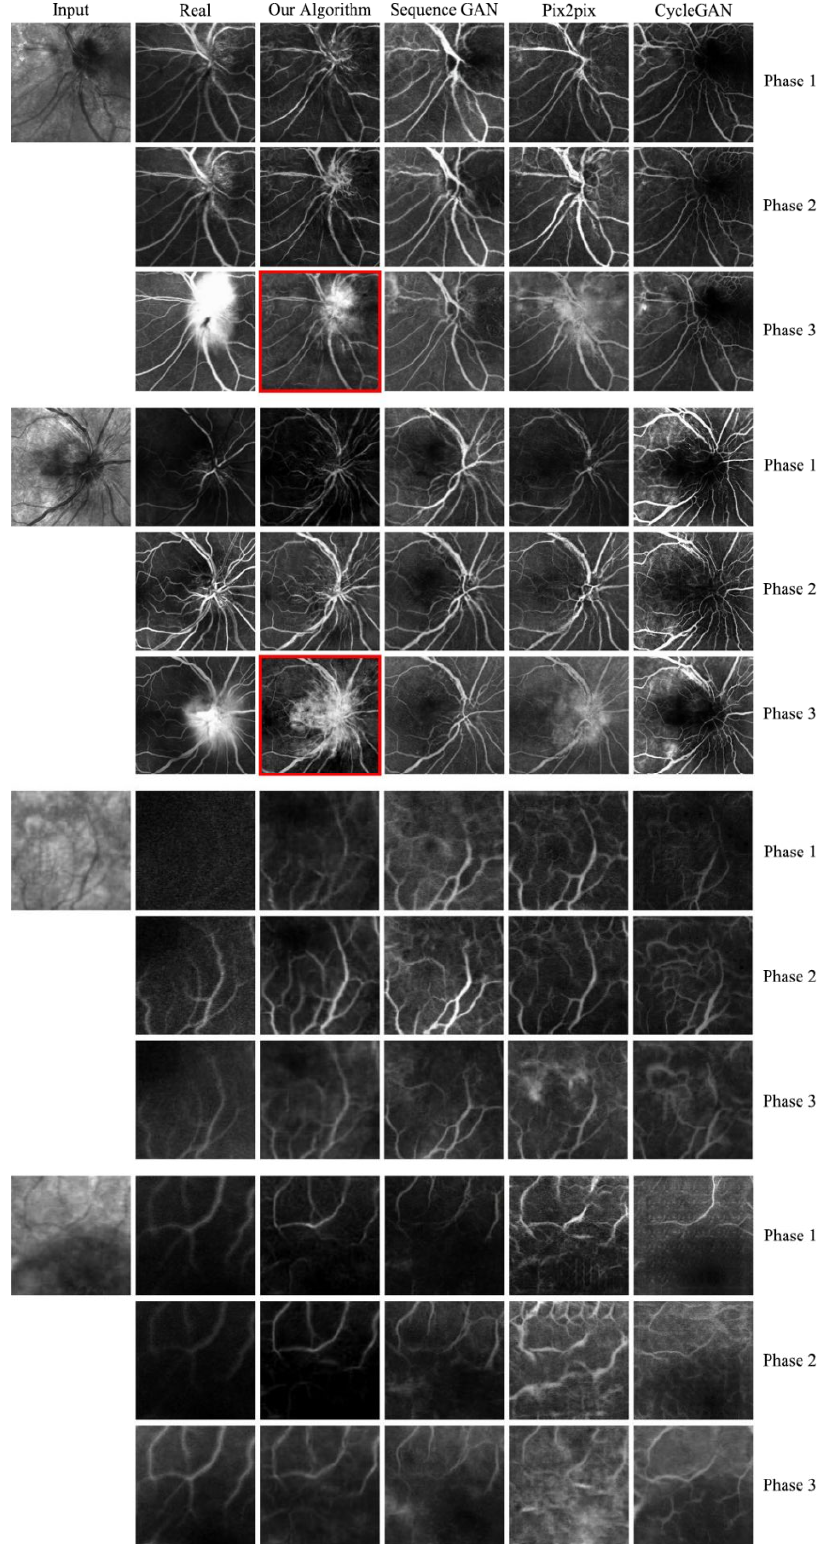
Figure 6. Qualitative comparison with state ‐ of ‐ the ‐ art methods using four examples. The first and the second example are from a wide field of view, and the third and fourth examples are from a narrow field of view. The images with red square boxes show our image translation performances of ONH leakages which are markedly better than the other